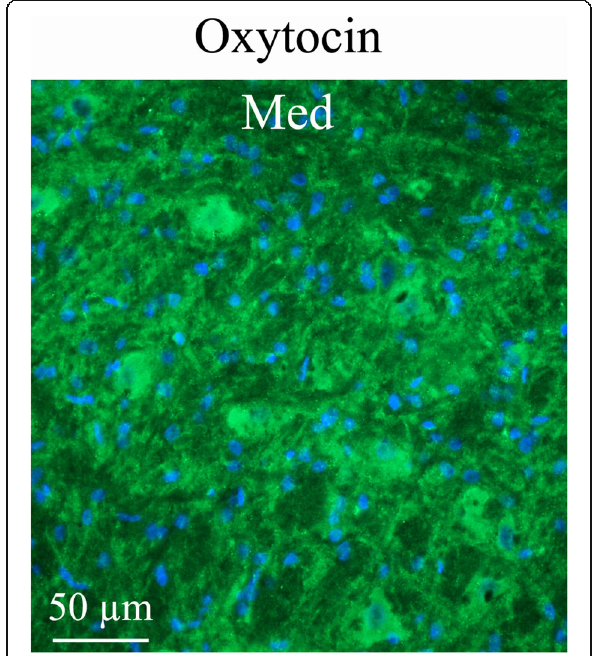
Fig. 6 Oxytocin immunohistochemistry of the medial cerebellar nucleus (Med). Med contained large neurons intermixed with small neurons. Med exhibited intense oxytocin fiber staining, often so close to the cell nuclei that it appears like cell body staining